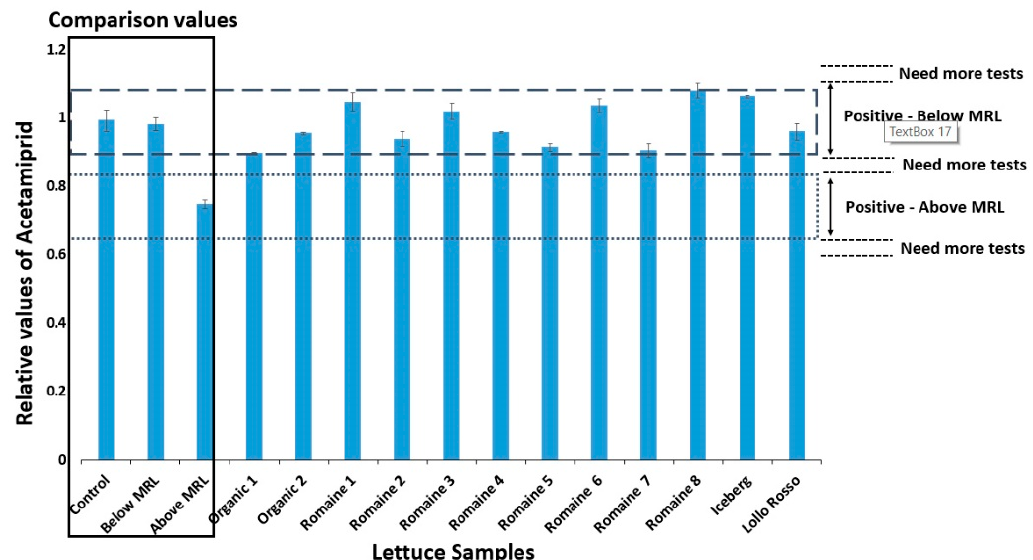
Figure 5. Relative values of lettuce extracts obtaining from a market and analyzed by biosensor system developed. The 96 time-series were obtained from the analysis and results were compared with the average of relative values from the database (columns: control, Below MRL, and Above MRL). The dashed line area corresponds to the Below MRL values and the area of the dots corresponds to the Above MRL values. If the values are at different points than the two areas mentioned above then the experiment has to be repeated. Table 1. Results of lettuce extracts obtaining from a market and analyzed by GC / MS a